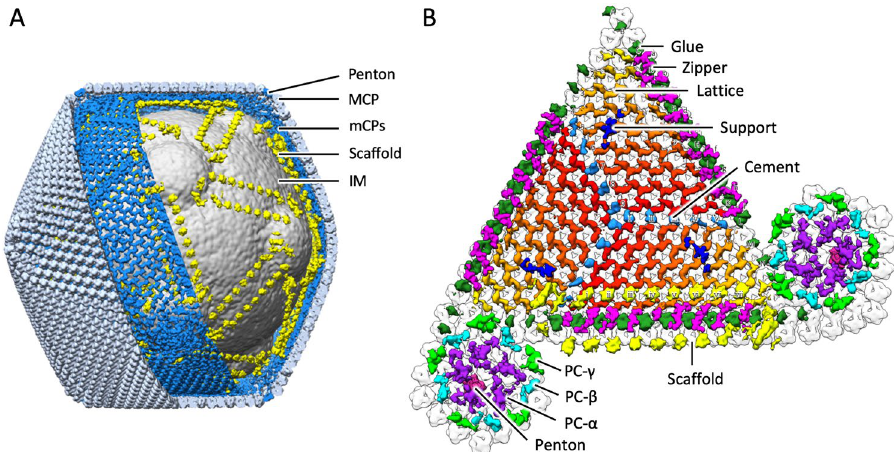
Figure 4. Segmentation of tokyovirus structure. ( A ) The complete tokyovirus virion cut out to show each component. Individual components of the virion; major capsid protein (MCP) layer (light blue), minor capsid protein (mCP) layer (blue), scaffold protein component (ScPC) array (yellow), and internal membrane (IM) (grey) are indicated. Individual segments are low-pass-filtered to improve visualisation clarity. ( B ) Focussed segmentation of mCPs, ScPCs (yellow), and penton (red purple) of tokyovirus. The mCPs, colored blue in ( A ), were classified into 8 components based on the structures, consisted of lattice component (LtC) (orange to red), support component (SuC) (royal blue), cement component (CmC) (sky blue), zipper component (ZpC) (pink), glue component (GlC) (emerald green), and 3 pentasymmetron components (PC-α, β, and γ) (purple, light green, and cyan). The isosurface is shown at 2